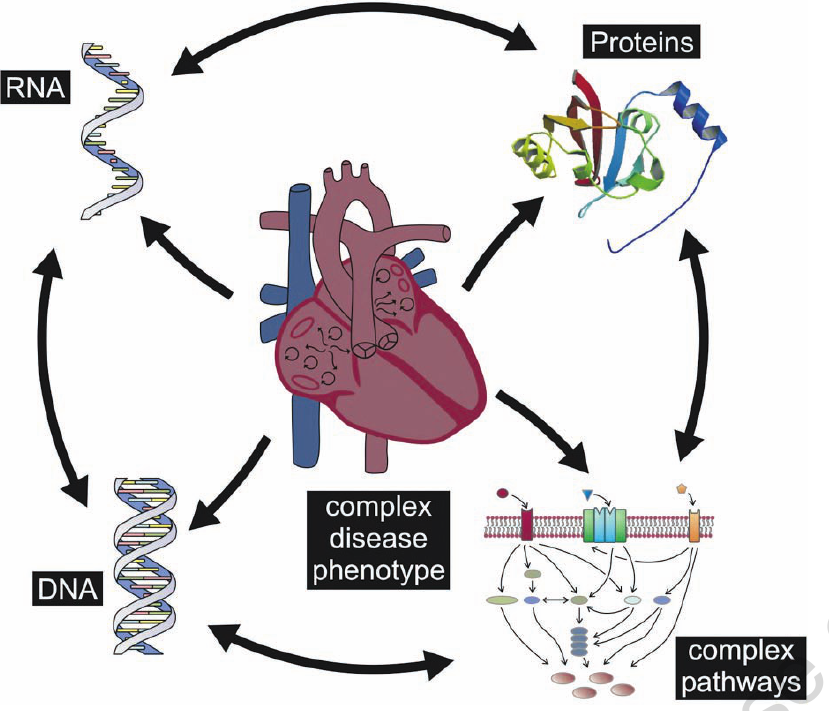
Figure 3. Schematic illustration of atrial fibrillation (AF) pathophysiology. A complex phenotype like AF cannot be explained by a single causal mechanism but rather by a com- plex interaction of different factors. Transcription, translation, protein subunit assembly or conformational changes as well as complex signaling pathways are involved in AF. These mechanisms interact with each other leading to AF development and are in turn influenced by